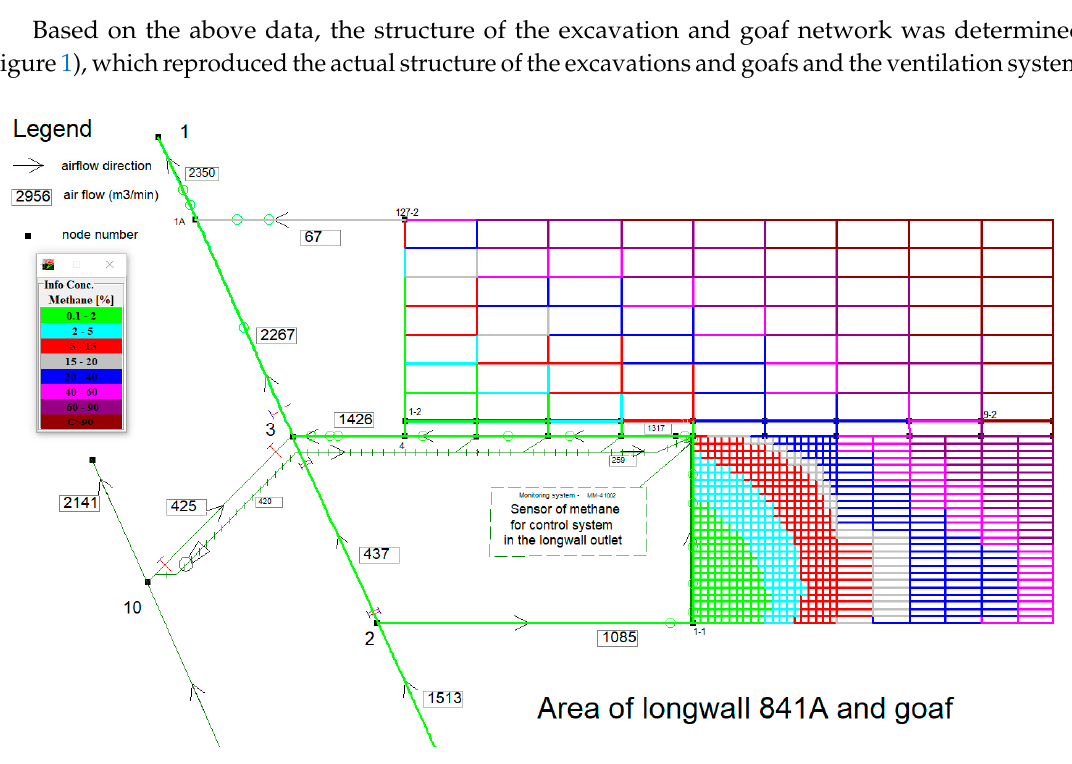
Figure 1. A ventilation scheme of the longwall 841A district with grids of goaf branches. Rectangles Figure1. Aventilationschemeofthelongwall841Adistrictwithgridsofgoafbranches. Rectanglesshow show the airflow volume stream (m 3 /min); arrows show the direction of flow. Numbers at junctions the airflow volume stream (m 3 / min); arrows show the direction of flow. Numbers at junctions highlight highlight their identification. their